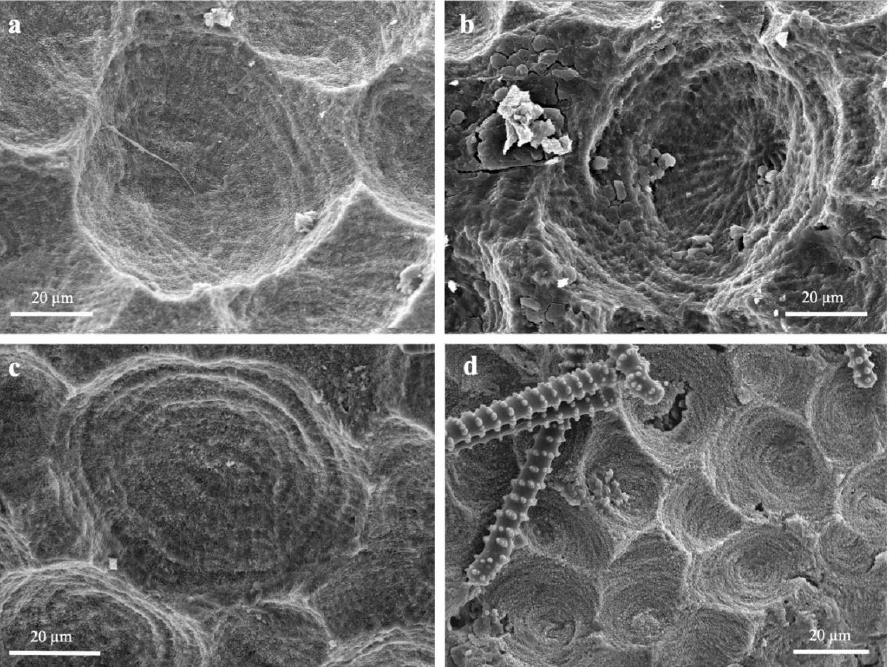
Figure 3. SEM images of sponge-generated bioerosion chambers, showing in the walls the characteristic pits of the different species recorded in the red coral samples: ( a ) Alectona millari ; ( b ) A. ricardi sp. nov.; ( c ) Thoosa armata ; ( d ) Dotona pulchella mediterranea . In c, the presence of radial scars superimposed on concentric lines was previously only reported by [15,16].